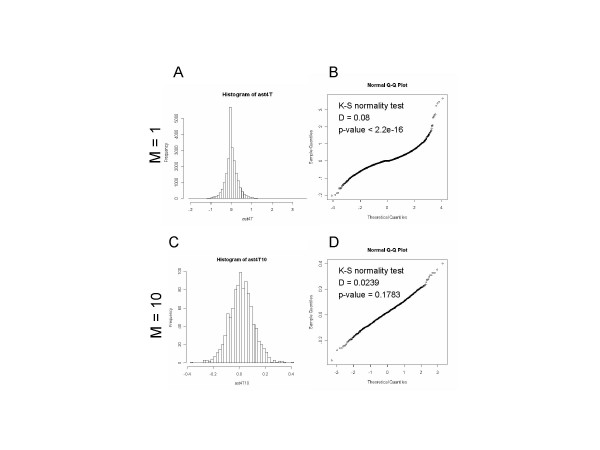
Distribution pattern of fold change values in a microarray data and determination of minimal gene set size in PAGE. A and B. A Histogram (A) and a quantile-quantile (Q-Q) plot against standard normal distribution (B) of fold change values from microarray data set. The diabetic muscle microarray data set [25] was analyzed as described in Methods section. The fold change values between normal and patient groups were calculated and used to draw histogram (A) and Q-Q plot (B). C and D. A Histrogram (C) and a Q-Q plot (D) of an average of 10 randomly sampled values from fold change values of diabetic muscle microarray data. Kolmogorov-Smirnov normality test was performed with a null hypothesis that distribution is normal. For the distribution of fold change values (A and B), the null hypothesis was rejected (D = 0.08, p-value < 2.2e-16). For the distribution of an average of 10 randomly sampled values from fold change values (C and D), the null hypothesis was not rejected (D = 0.0239, p-value = 0.1783).